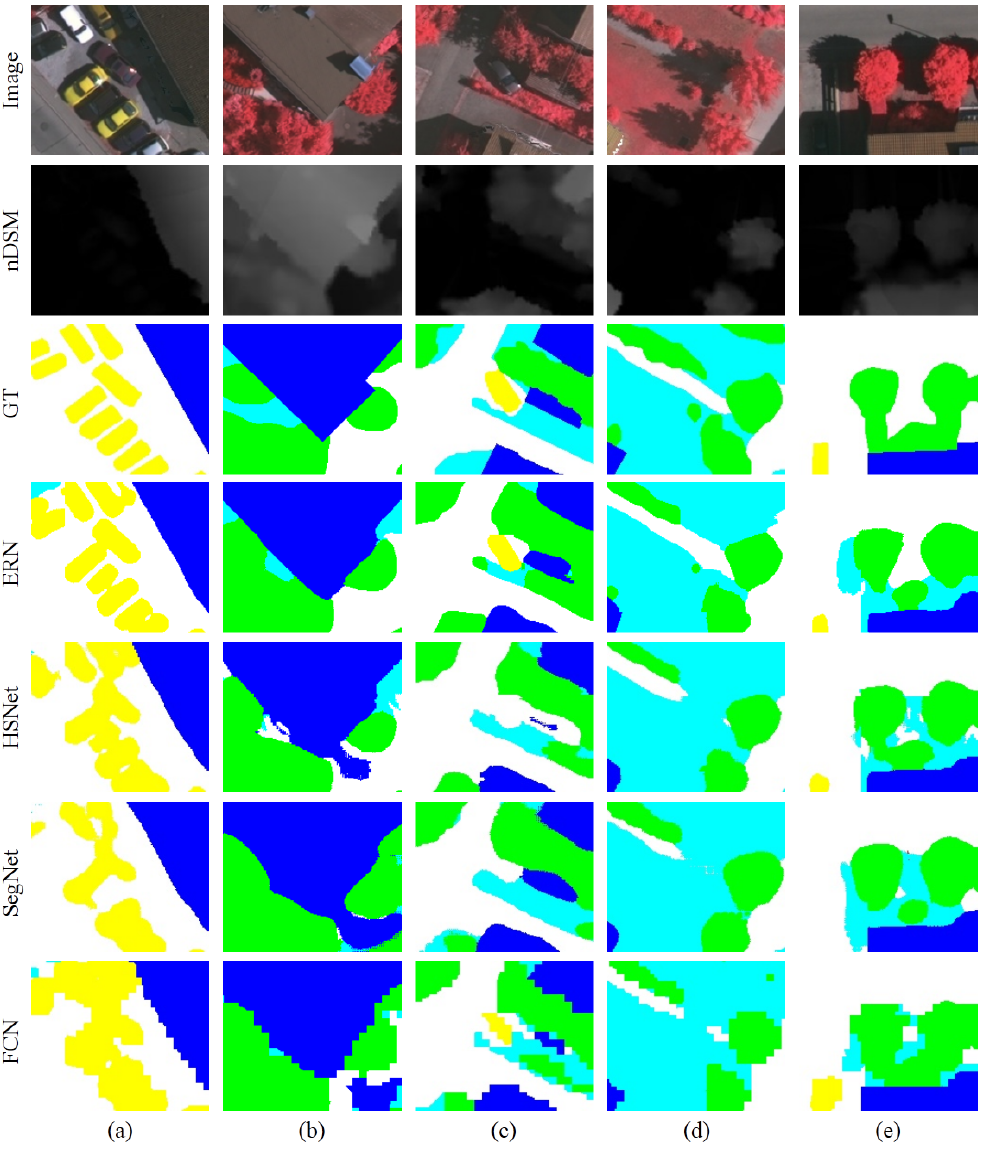
Figure 9. Semantic segmentation results for some local details of the ISPRS Vaihigen Dataset. ( a ) area with dense cars; ( b ) similar appearance between a building and its surroundings; ( c – e ) shadow-affected regions; white: impervious surfaces; blue: buildings; cyan: low vegetation; green: trees; yellow: cars; red: